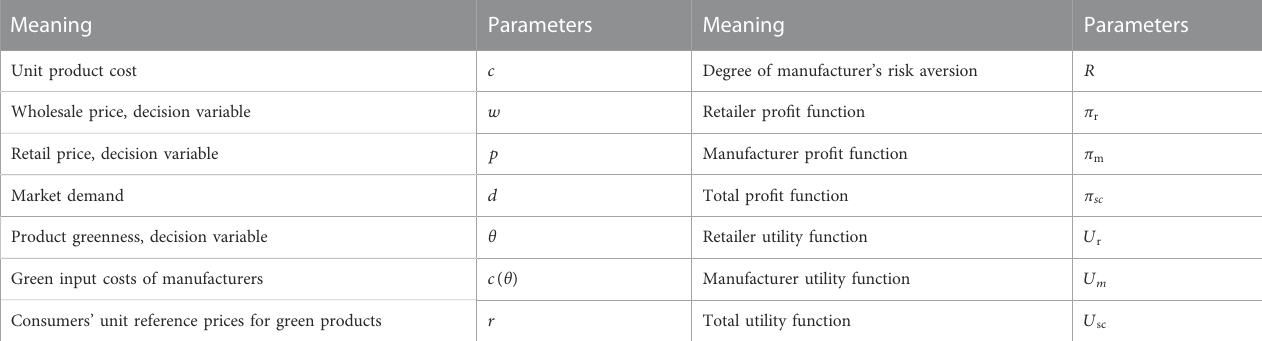
TABLE 2 Relevant parameter